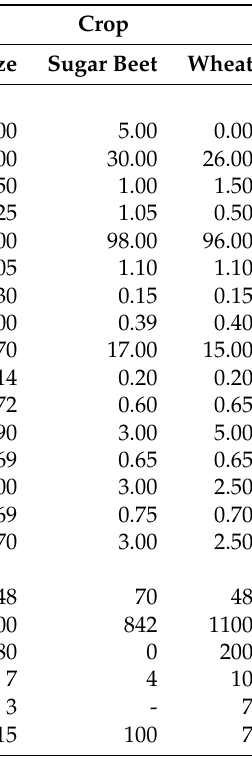
Figure 4. Minimum and maximum temperature ( T min and T max ), reference evapotranspiration ( ETr ), and precipitation ( PP ) for the study area, presented as mean values from 1970 to 2014. Table 1. Conservative (constant) and generally applicable parameters for maize, sugar beet, and wheat in the Central Valley of